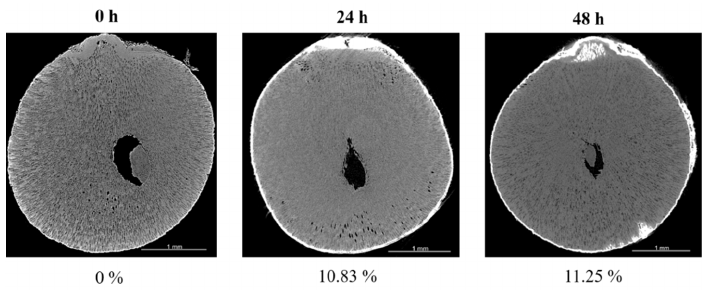
Figure 6. Mapping of hydration volume percentage inside dried mechanically scarified seeds of G. superba using micro-T and phosphotungstic acid (PTA) stain (at 0, 24, and 48 h of imbibition).